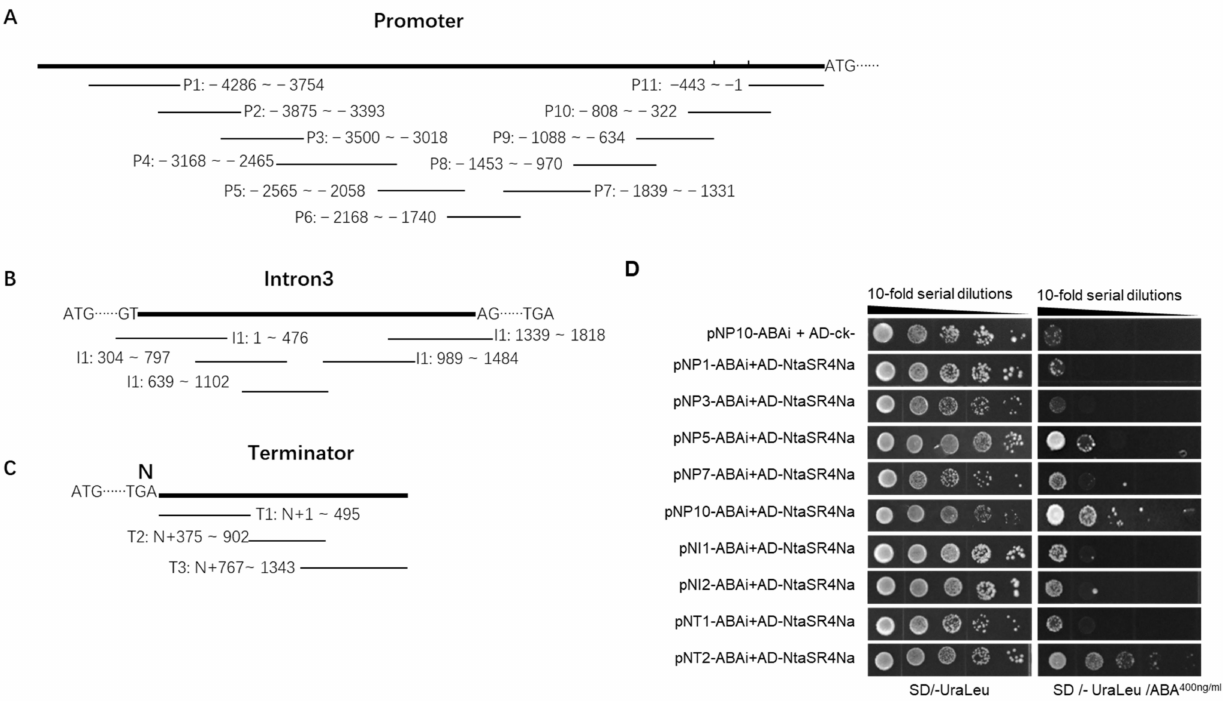
Figure 1. Interaction between NtaSR4N and the N gene in a yeast one-hybrid assay. ( A – C ) Diagrams of N promoter, Intron 3, and terminator DNA fragments used in bait vectors. ( D ) Point-to-point Y1H tests. Bait and prey vectors in each yeast strain are indicated to the left. Medium composition is indicated at the